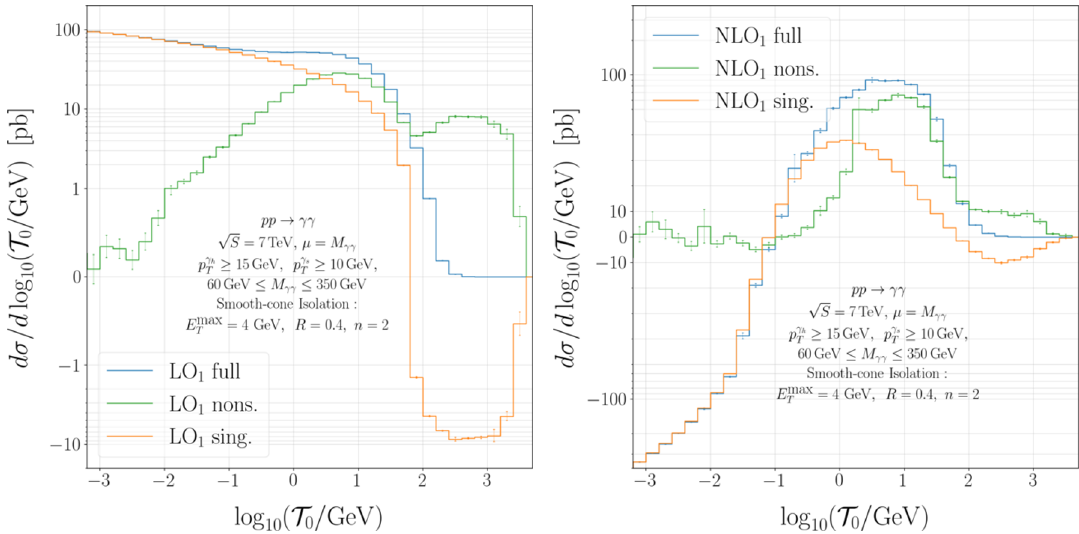
Figure 1 . Singular and nonsingular contributions to the diphoton production cross section as a function of T 0 at NLO (left) and NNLO